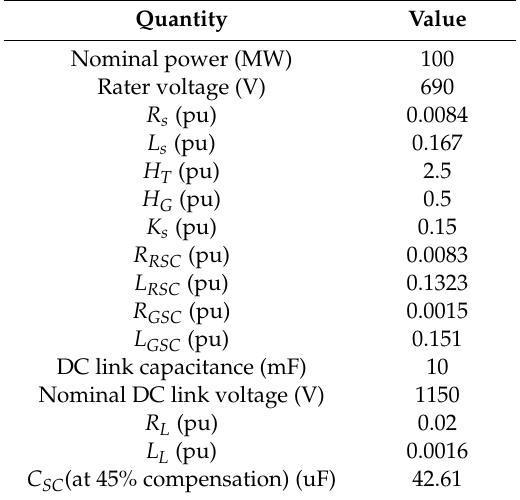
Table 1. Parameters of series-compensated DFIG-based wind farm.